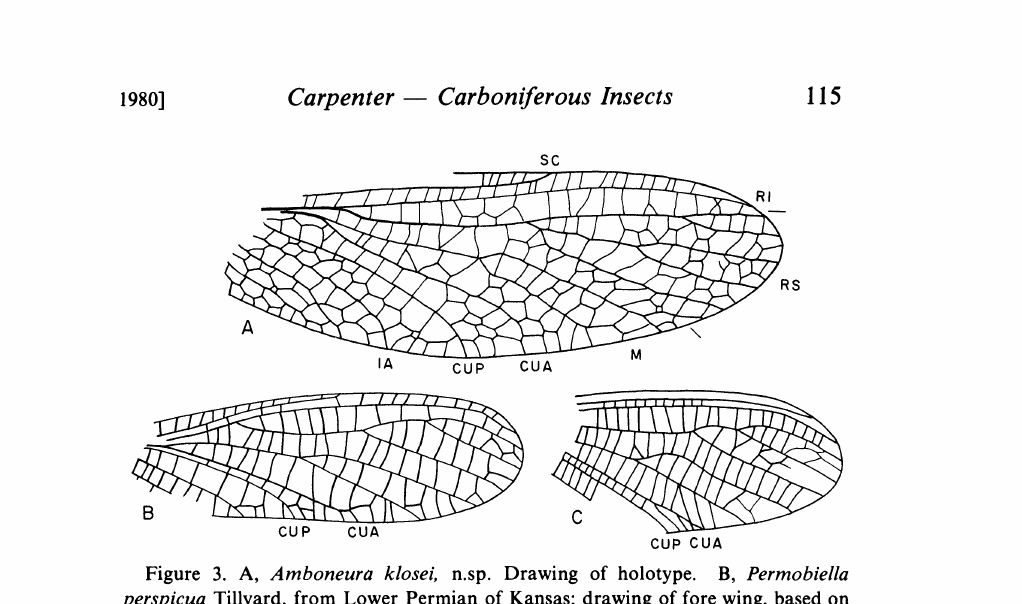
Figure 3. A, Amboneura klosei, n.sp. Drawing of holotype. B, Permobiella perspicua Tillyard, from Lower Permian of Kansas; drawing of fore wing, based on holotype, no. 15593, Peabody Museum. Length of wing as preserved, 11 mm. C, Caloneurella carbonaria Carpenter, from Upper Carboniferous of Pennsylvania; drawing of wing, based on holotype, no. 6894/6895, Carnegie Museum, Pittsburgh. Length of wing, as preserved, 155 mm. SC, subcosta; M, media; CUA, anterior cubitus; other lettering as in figure